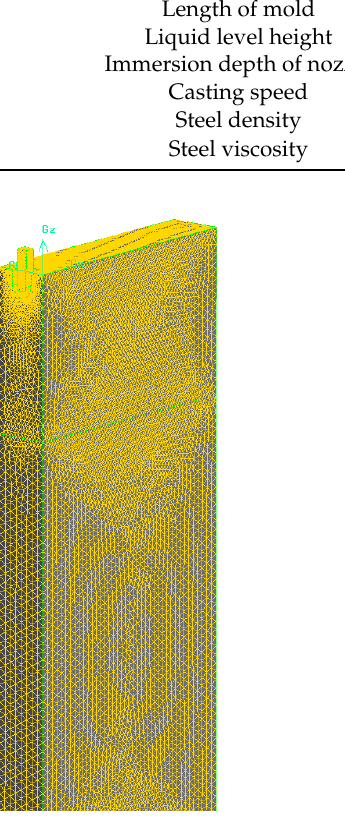
Figure 2. The mesh of the model. x, y, z are the directions. Here are the assumptions.